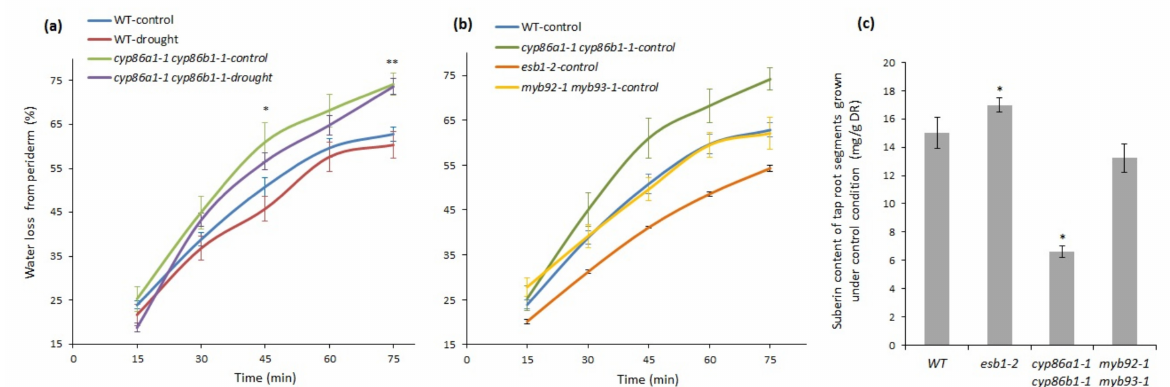
Figure 7. Comparison of amount of water loss from root periderm segments in the wild type and mutants altered in total poly-aliphatic suberin. ( a ) Amount of water loss in the wild type and cyp86a1-1 cyp86b1-1 under control and drought conditions. ( b ) Amount of water loss in wild-type, cyp86a1-1 cyp86b1-1, esb1-2 , and myb92-1 myb93-1 tap root periderm segments under control condition ( n = 5, with each replicate representing three root periderm segments from different plants). Values are the mean ± SD of five replicate samples. Significant differences in ( a ) between wild-type drought and cyp86a1-1 cyp86b1-1- drought conditions are shown by asterisks (* p < 0.05 and ** p < 0.01 calculated by Student’s t -test). ( c ) Total suberin content from wild-type, cyp86a1-1 cyp86b1-1 , esb1-2 , and myb92-1 myb93-1 periderm segments. ( n = 4–5, with each replicate representing roots from four pooled plants at 4 weeks of age). Asterisks in ( c ) indicate significant differences by Student’s t -test at p ≤ 0.05 comparing wild-type and